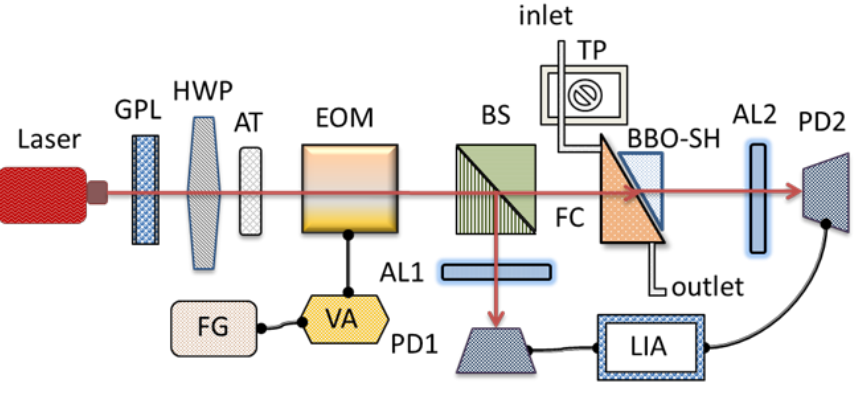
Figure 2. Schematic illustration of the measurement